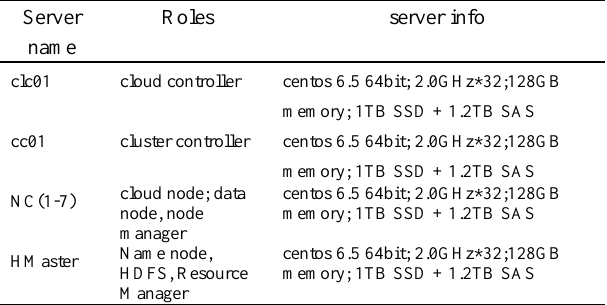
Figure 4.1. DC2 auto-scaling mechanism